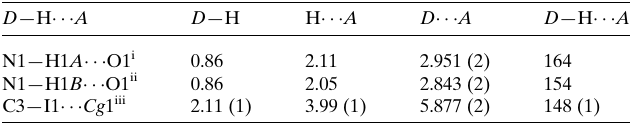
Table 1 Hydrogen-bond geometry (A˚ , (cid:3) ) for (I). Cg 1 is the centroid of the C2–C7 phenyl ring.